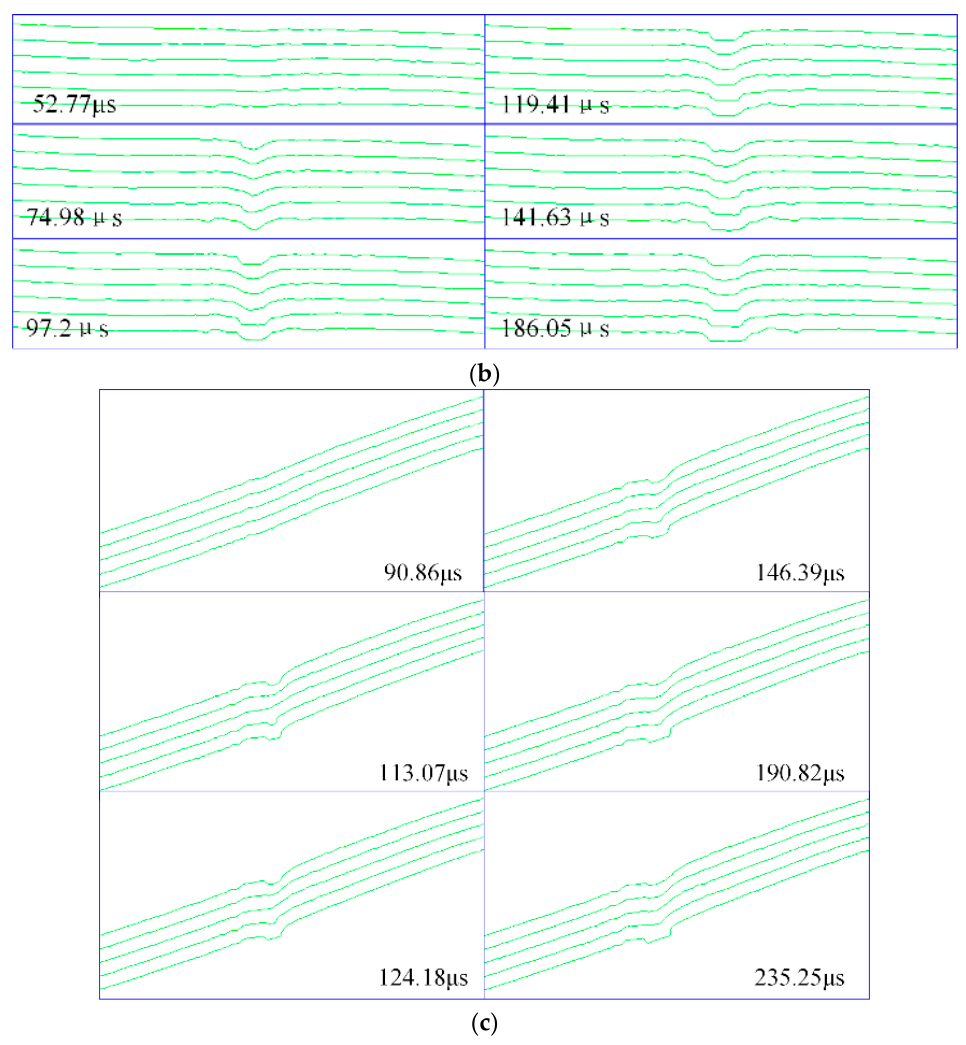
Figure 7. Interference fringes: ( a ) cone terminal, radius of curvature = 2.5 mm; ( b ) cone terminal, radius of curvature = 5 mm; ( c ) spherical terminal, diameter = 40 mm.